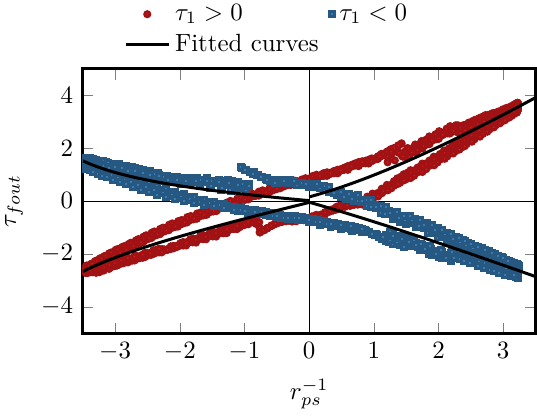
Figure 14. Stiction, measurements and fitted